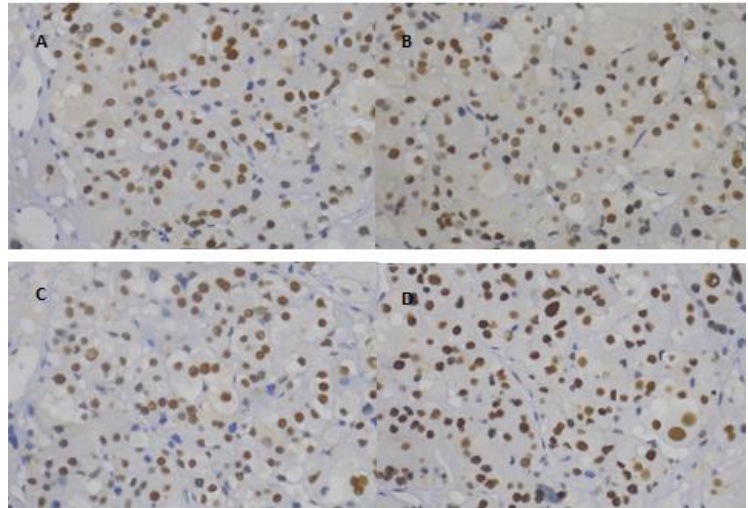
Figure 1. Representative adrenocortical tumor of a female patient, 2.7 years of age, with mutation